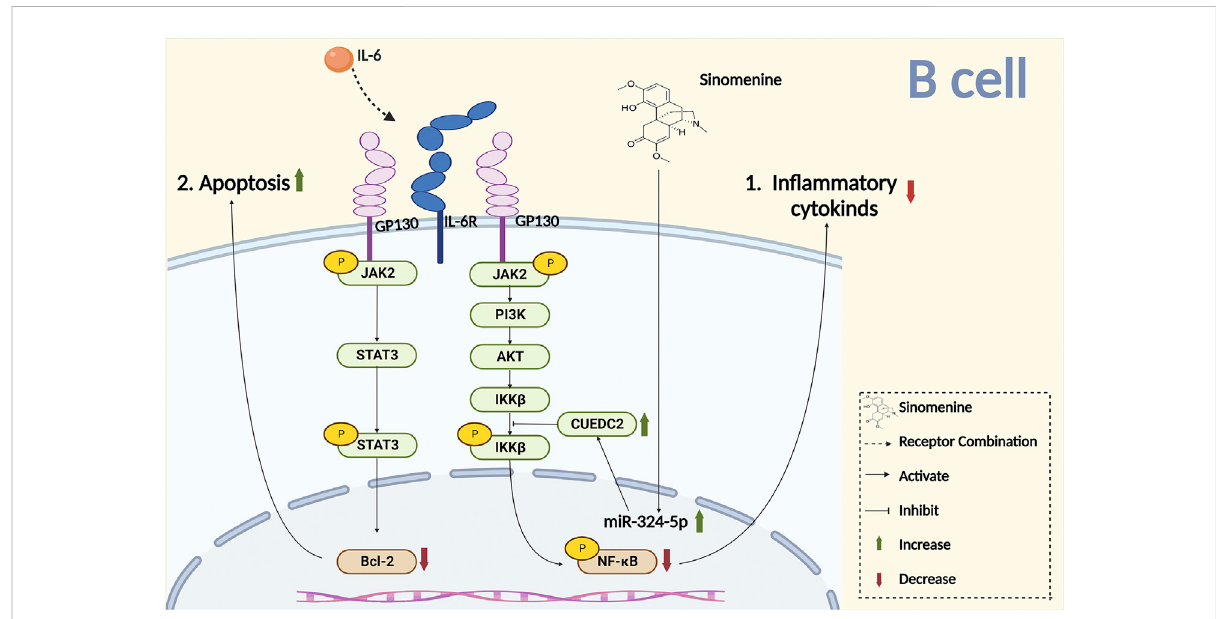
FIGURE 5 Sinomenine inhibits chronic pain by promoting B cell apoptosis and inhibiting the release of in fl ammatory cytokines.